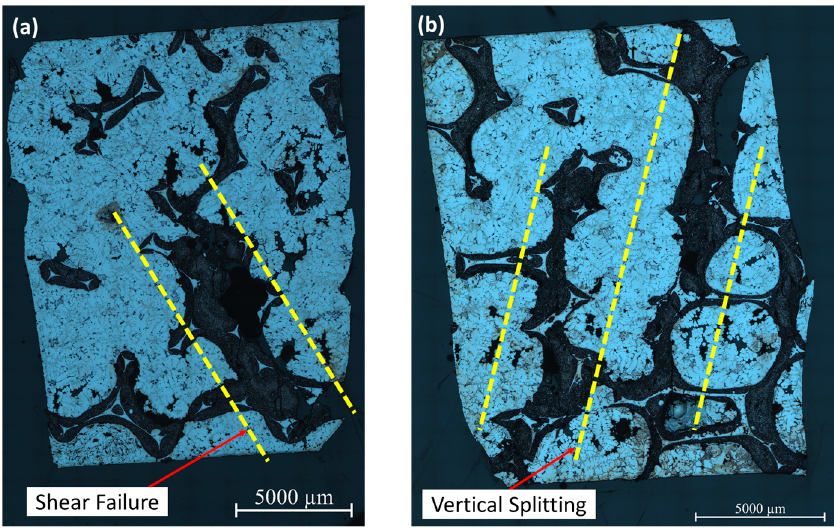
Figure 9. Optical micrograph of post ‐ tested C4 composite ( a ) C4 ‐ F10 ( b ) C4 ‐ F20.